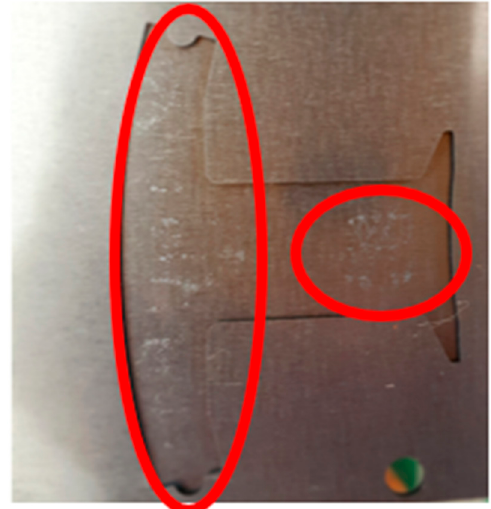
Figure 13. The experimental results of the Case 2 dipping process.